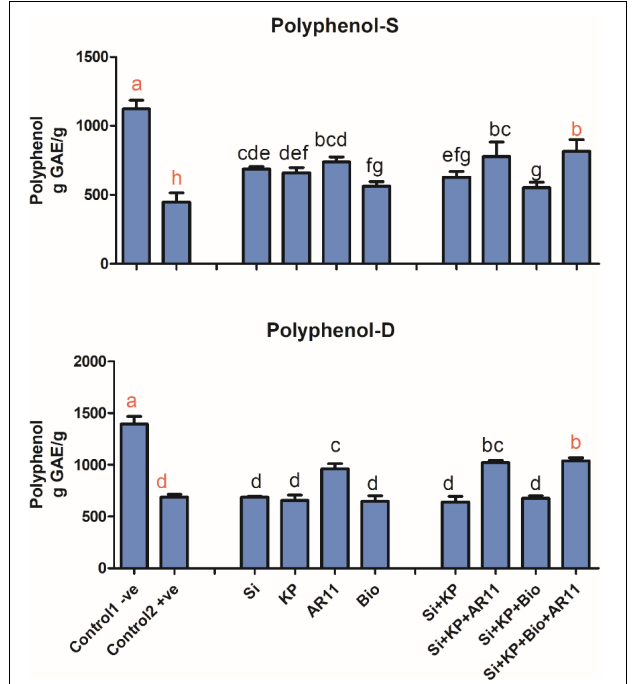
FIGURE 7 | Effect of co-application (AR11, Si, K 2 HPO 4 , and biochar) on the phenolic level of plant shoots under salt and drought stresses. (-S), salt; (-D), drought. Error bars represent standard deviations. Each data point represents the mean of at least three replications. Bars with different letters are significantly different from each other at P ≤ 0.05.